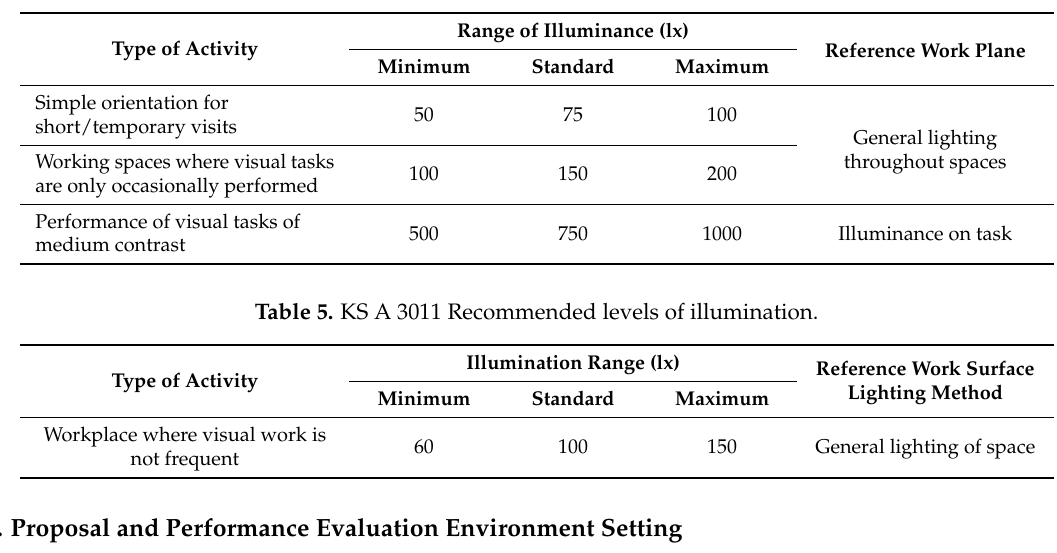
Table 4. Illuminating Engineering Society (IES) indoor illumination standards.